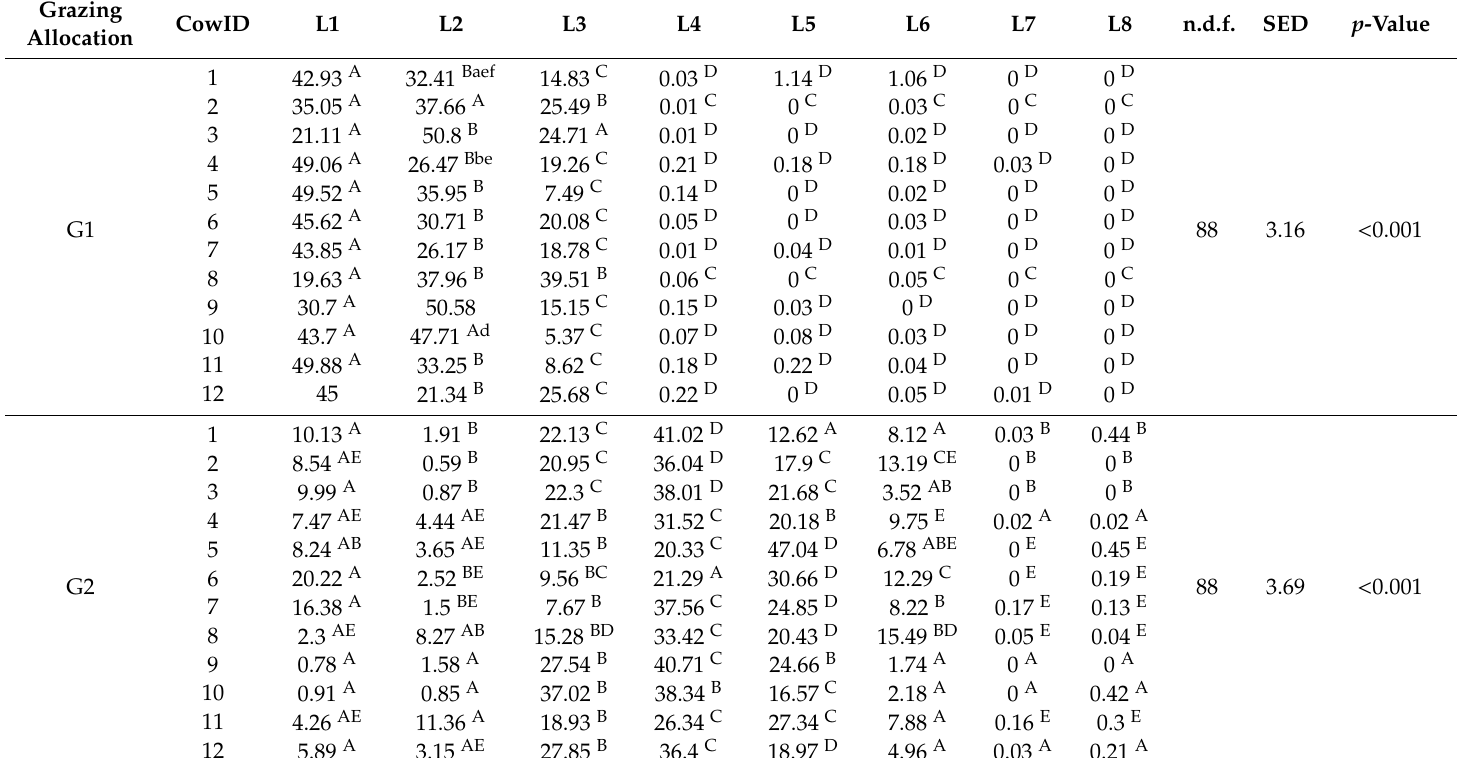
Table 2. Variation in the proportion of time individual cows were in locations L1 to L8 in grazing allocations G1 and G2 with standard error of the di ff erences (SED). A–E For each cow, di ff erent superscripts denote significant di ff erence between